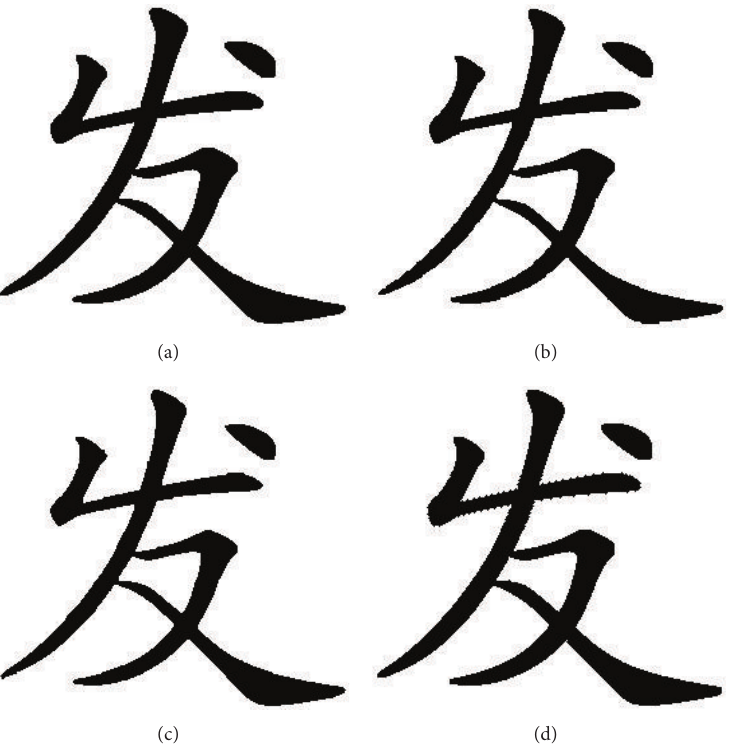
Figure 15: Flip the scaled font binary image; flipping count is 800 pixels: (a) original font binary image; (b) scaled font binary image which used our proposed interpolation algorithm; (c) flipped font binary image using our flipping strategy; (d) flipped font binary image using Wu’s